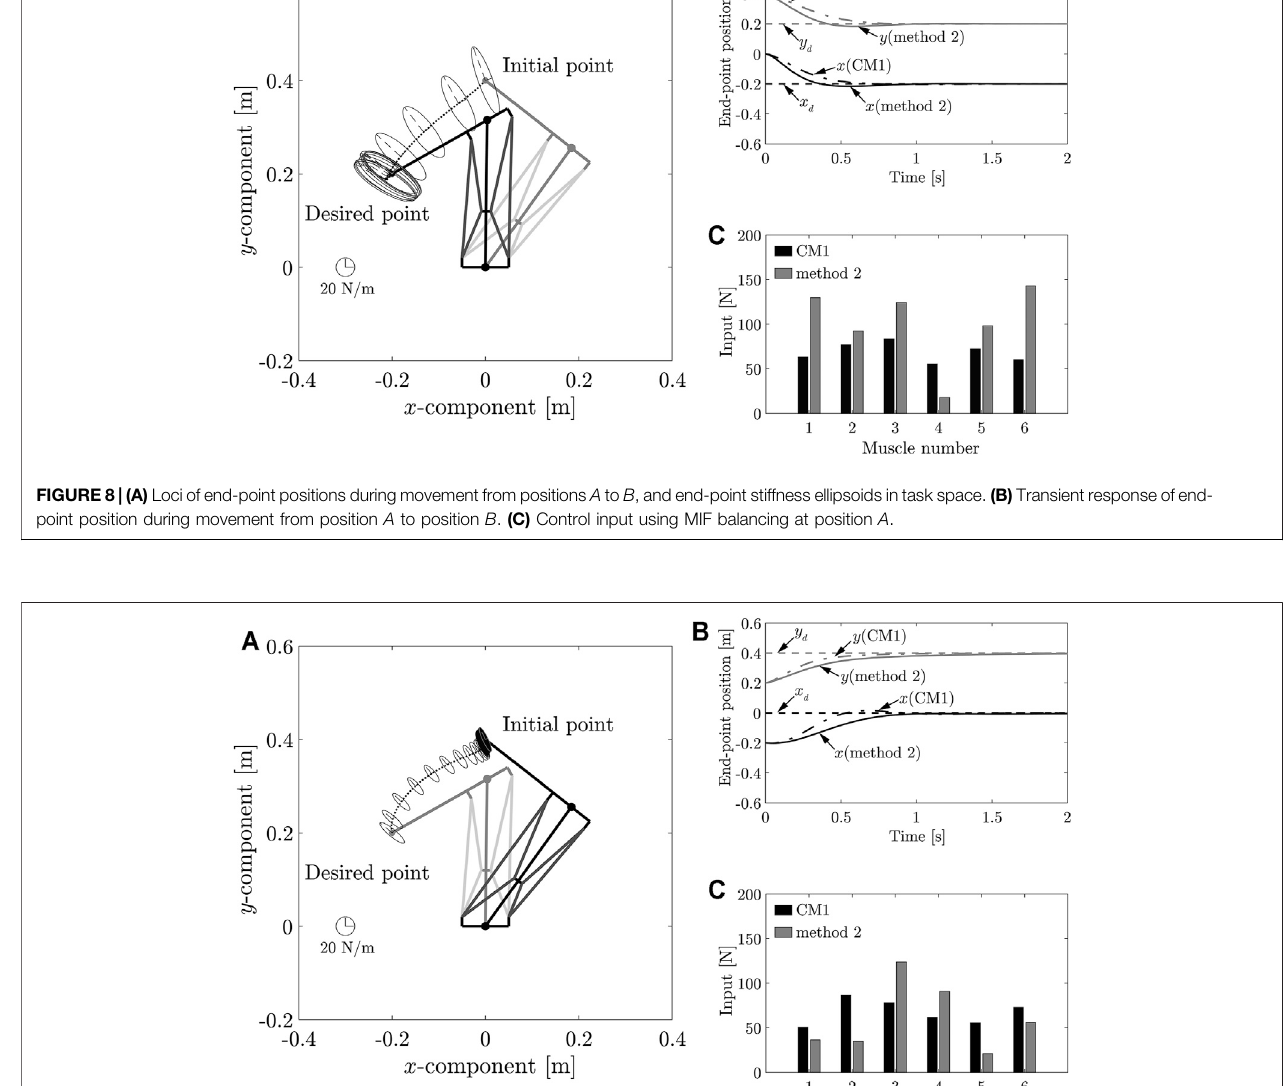
Frontiers in Robotics and AI |